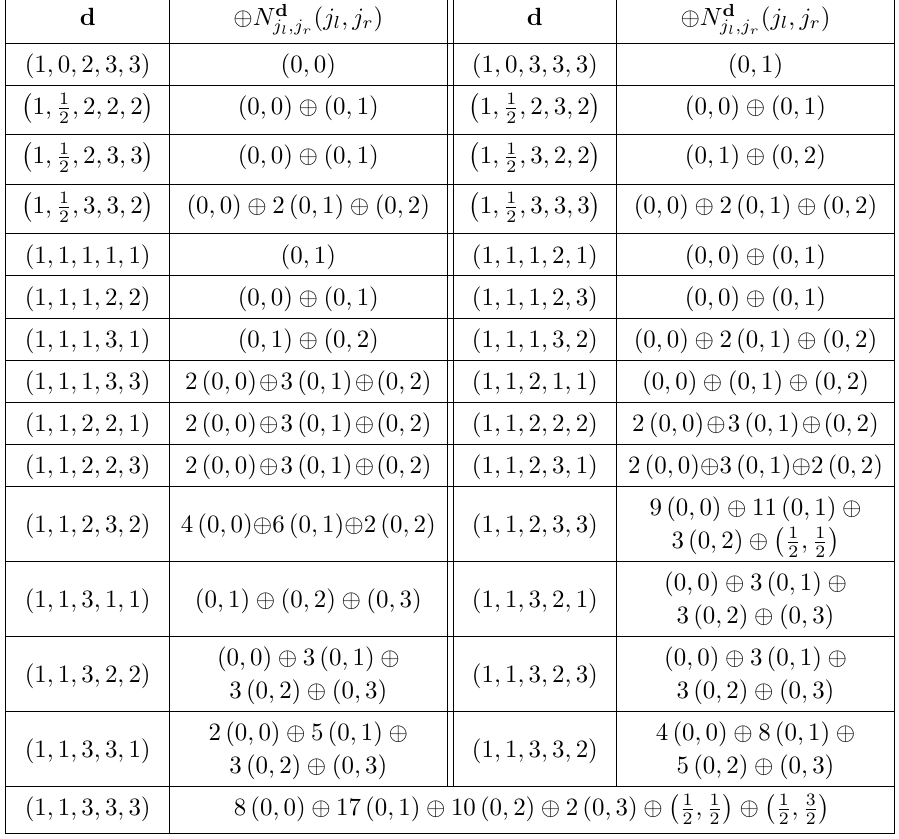
Table 31. BPS spectrum of SO(8) gauge theory with Z 2 twist for d 1 = 1 , d 2 ≤ 1 and d 3 , 4 , 5 ≤ 3 . Here, d = ( d 1 , d 2 , d 3 , d 4 , d 5 ) labels BPS states with charge d 1 Φ + d 2 τ + d 3 α 1 + d 4 α 2 + d 5 α 3 ,